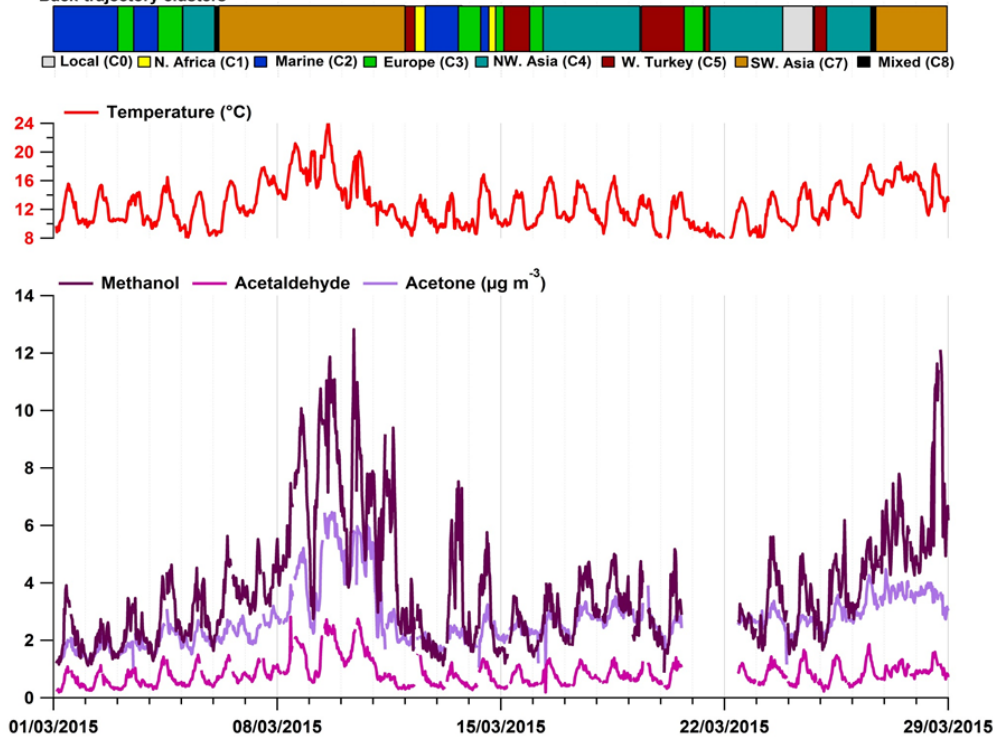
Figure 6. Time series of a selection of OVOCs (methanol, acetaldehyde and acetone – purple lines), temperature (red line) and air mass origin